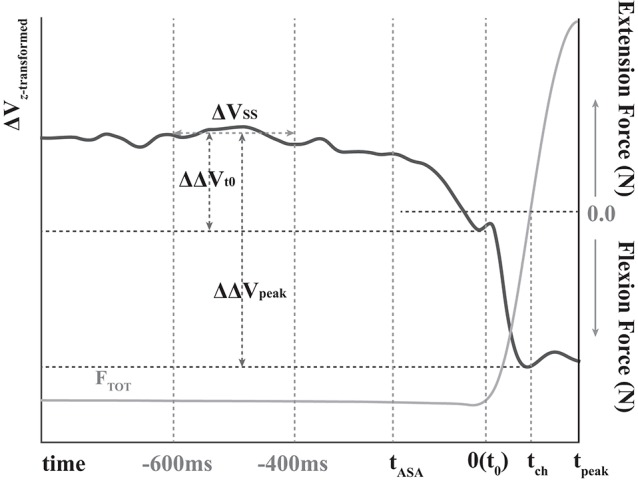
The sample data of total force (gray line) and variance of the total force (z-transformed ΔV, black line) during quick pulse force production tasks. Flexion forces are presented as negative, and extension forces are presented as positive. tASA, t0, tch, and tpeak stand for the time of anticipatory synergy adjustment (ASA), the time of initiation of total force(FTOT) change, the time of the direction of force changed, and of the peak pulse force, respectively. ΔVSS represents average ΔV at a steady state. ΔΔVt0 and ΔΔVpeak stand for the change in the synergy index between steady state and t0 and between the steady state and negative peak of ΔV after t0, respectively.